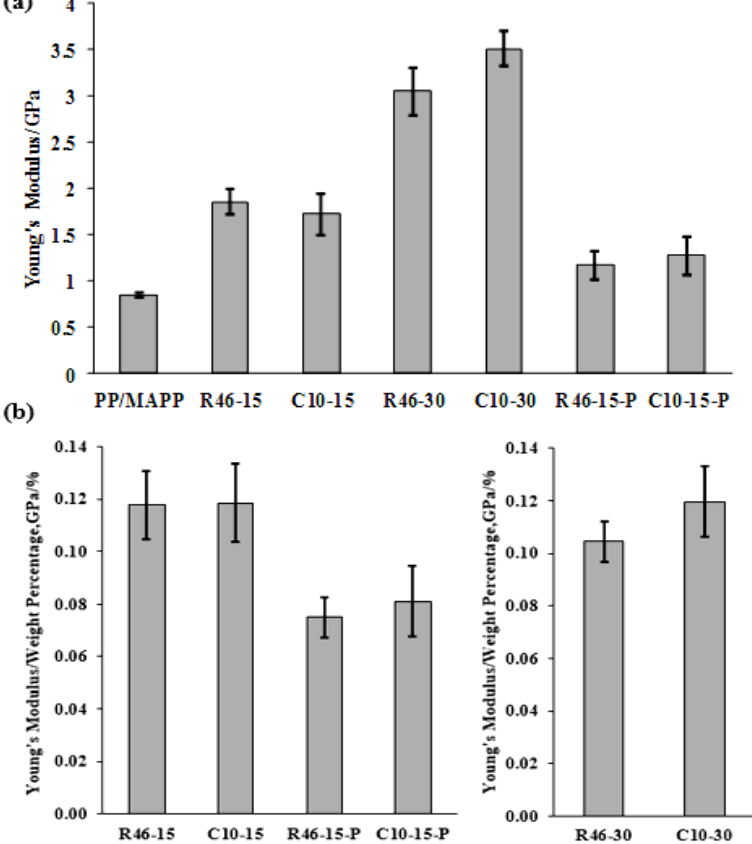
Figure 15. Graphs representing: ( a ) Young’s modulus and ( b ) Young’s modulus/weight percentage* of various composites. Weight percentage = weight percentage of fibres.